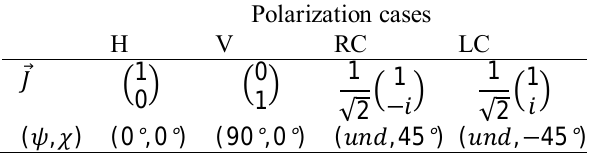
Where (cid:1829) (cid:2869)(cid:2869) = 〈 | (cid:1829)(cid:1842) (cid:2869) | (cid:2870) 〉 , (cid:1829) (cid:2869)(cid:2870) = (cid:1829) (cid:2869)(cid:2870)∗ = 〈(cid:1829)(cid:1842) (cid:2869) ∗ (cid:1829)(cid:1842) (cid:2870)∗ 〉 and | (cid:2870) 〉 . (cid:1829) (cid:1829) = 〈 | (cid:1829)(cid:1842) (cid:2870)(cid:2870) (cid:2870) (cid:3030)(cid:3043) , is Hermitian and provides four measurements, two real diagonal terms and the real and imaginary parts of one of the off-diagonal